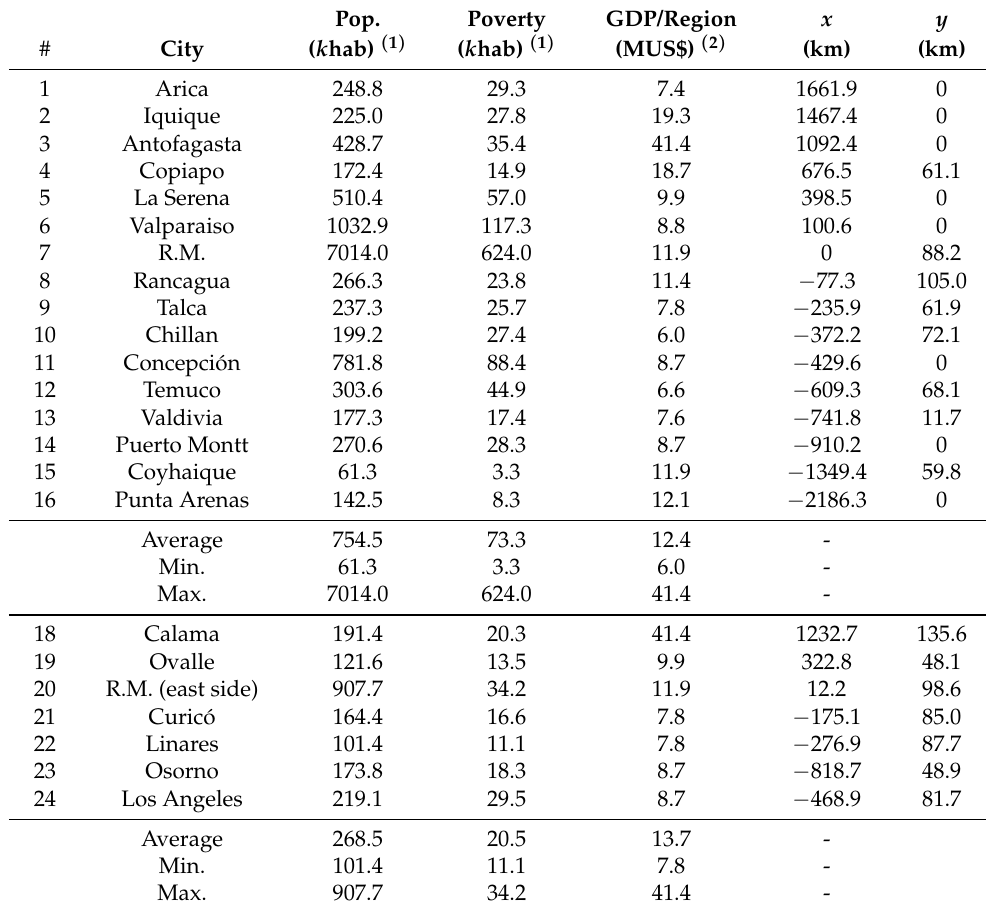
Table 1. Cadaster of Chilean cities ordered from north to south. Big cities: 1 to 16 ; small cities: 17 to 23. ( 1 ) k hab = thousands of habitants, ( 2 ) MUS$ = millions of dollars (conversion rate